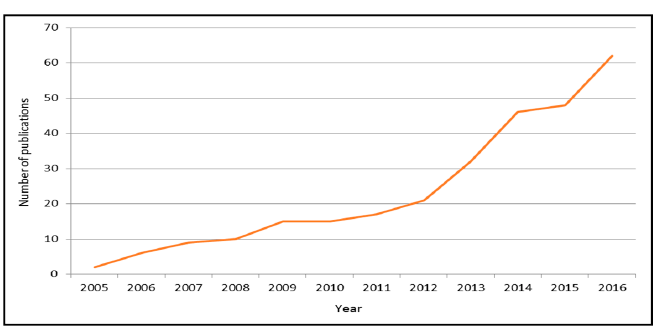
Figure A1. Classification of articles by publication year.